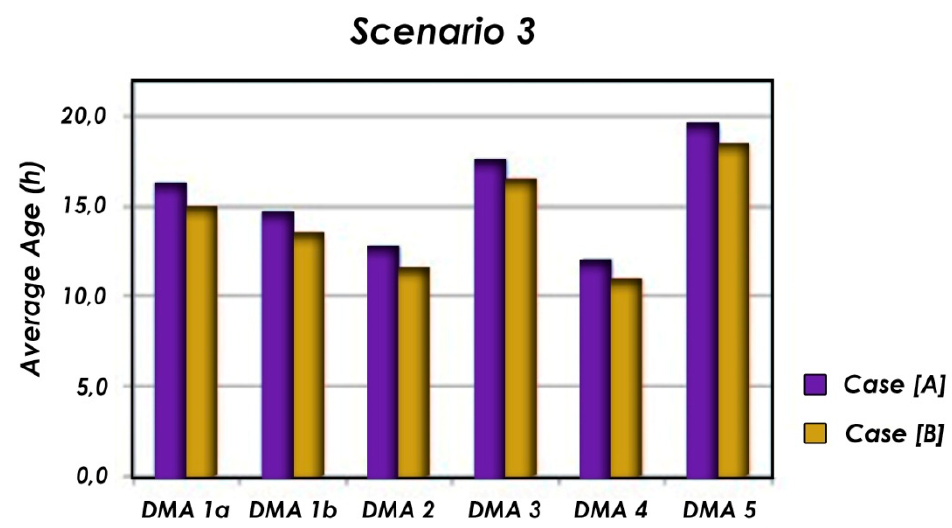
Figure 13. Water Age for scenarios A and B.